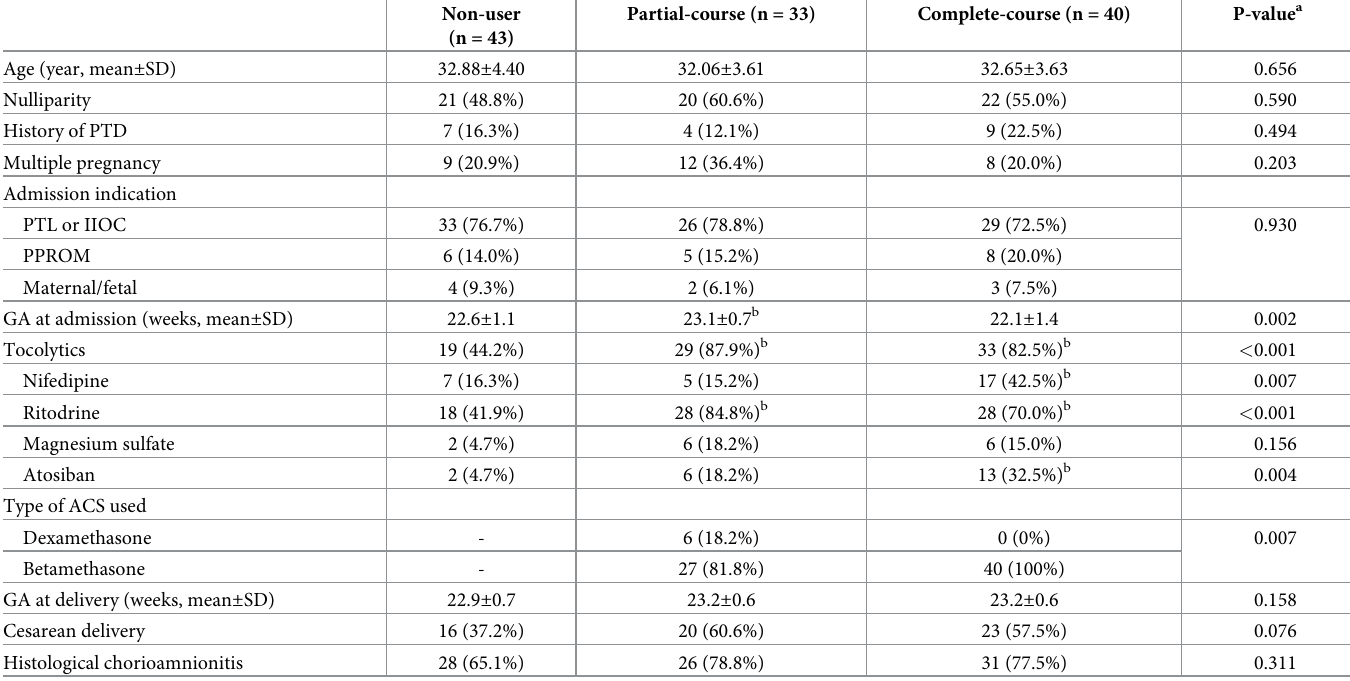
Table 3. Maternal characteristics and pregnancy outcomes according to exposure to antenatal corticosteroid